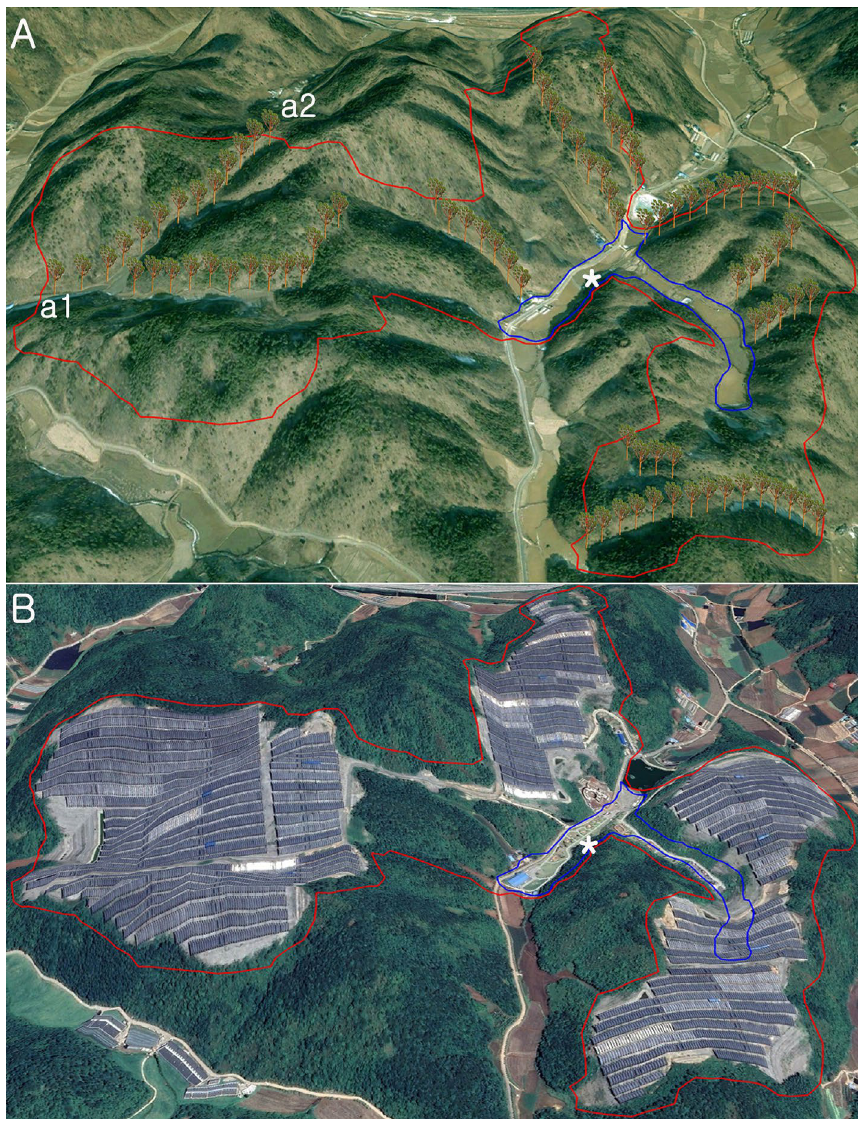
Figure 3. The forest-photovoltaic solar tree simulated a forestry landscape before flat agrophotovoltaic panel construction; see Fig. 2 for the location of the image. ( A ) Forest-photovoltaic solar tree simulation, a1-a2: example of hiking trail-based installation (slope distance: 1300 m), the total of 13 solar trees were installed based on one tree criteria per 100 m. ( B ) Damaged forestry landscape after the flat agrophotovoltaic panel installment: The reddish polygon represents coverage of solar plant while the blue polygon represents an agricultural field, including a farm road. A magnified portion of the blue polygon area is displayed in Fig. 4: * represents the location of the agricultural field at the study site. The scale bar is not inserted because the horizontal and vertical scales change depending on the viewing point in the 3D image. Time series images (2005 and 2020) were obtained from Google Earth Pro 7.3.4 (https:// www. google. com/ earth/ versi ons/# earth- pro). The map created in Google Earth Pro 7.3.4 and Adobe Photoshop CS3 (https:// adobe- photo shop- cs3- update. en. softo nic.